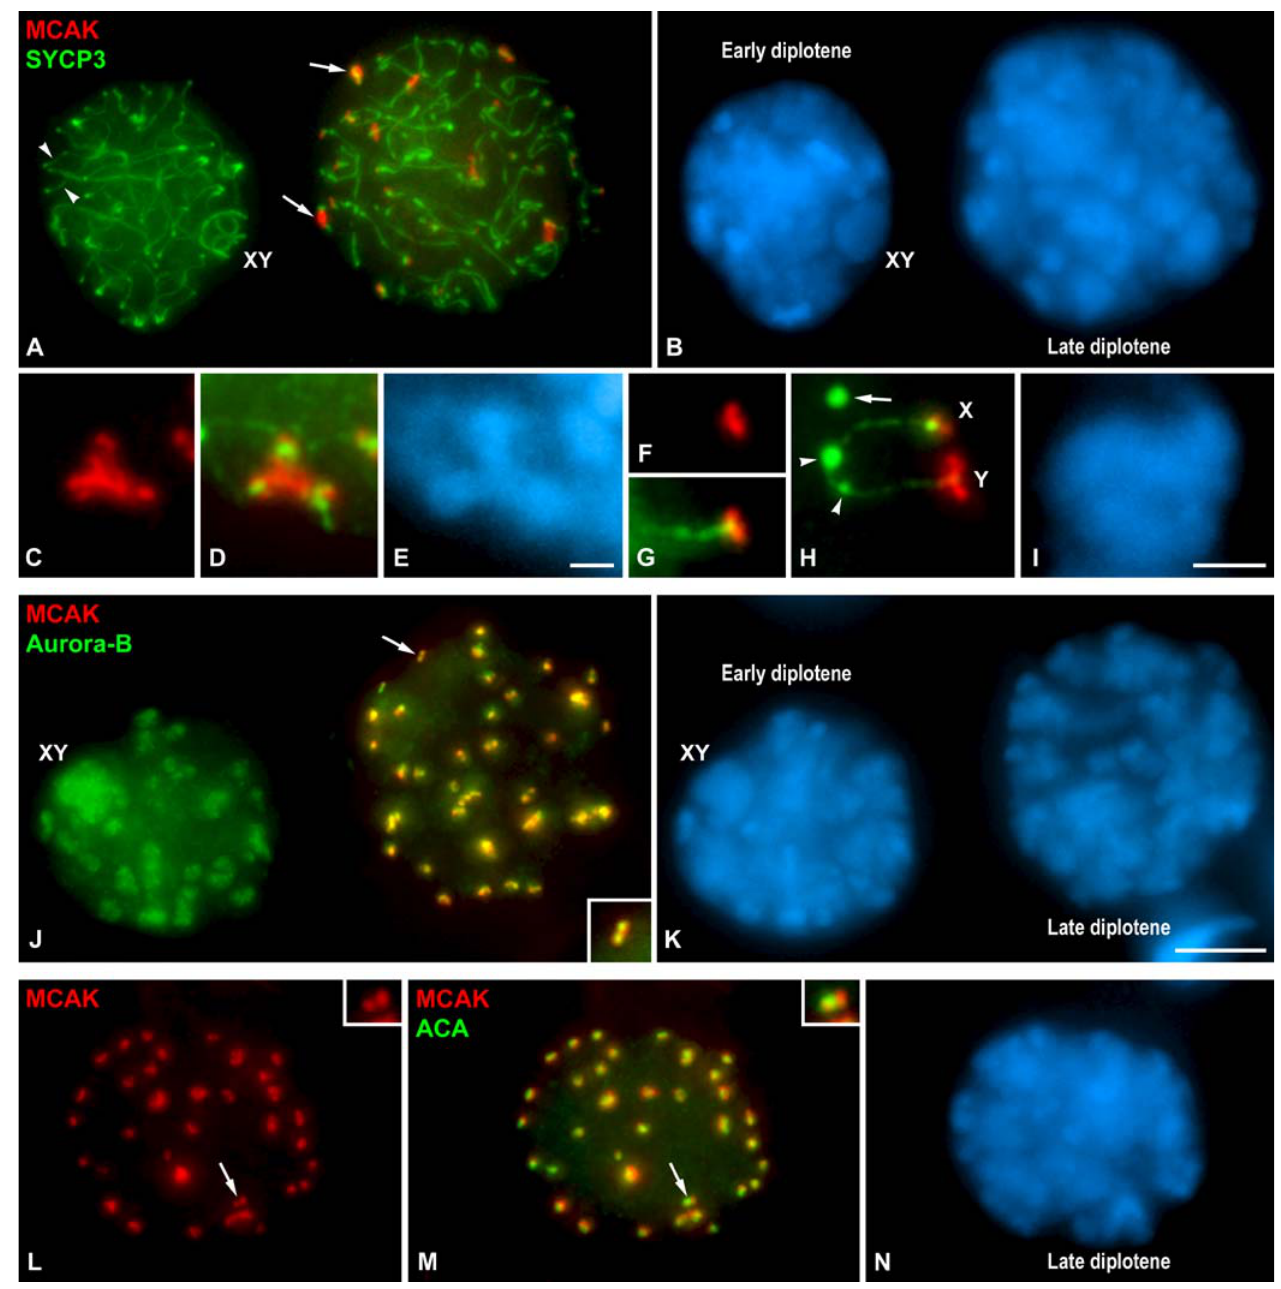
Figure 1. MCAK Is Loaded at Centromeres after Aurora-B in Late Diplotene MCAK is labelled in red and SYCP3 (A–I), Aurora-B (J,K), and kinetochores (L–N) are labelled in green. In merged images colocalisation regions appear in yellow. DNA appears in blue. Most images are z-projections of several focal planes throughout the spermatocytes shown. (A and B) Early and late diplotene spermatocytes. At early diplotene SYCP3 labels desynapsing LEs (arrowheads in [A]), and the X and Y axial elements (XY). At this stage no MCAK labelling can be detected. Nevertheless, during late diplotene, when most LEs are desynapsed, MCAK can be detected as small dots at one of their ends (arrows in [A]). (C–E) Single focal plane of a late diplotene chromocentre. MCAK occupies part of the heterochromatin and colocalises partially with the proximal ends of three desynapsed LEs detected with SYCP3. (F and G) Single focal plane of the centromeric region of a late diplotene autosome. MCAK is detected as two dots at the end of a desynapsed LE. (H and I) Projection of three focal planes of the sex bivalent (X,Y) in diakinesis. While the Y centromere appears scarcely stained for SYCP3, MCAK shows an intense T-like labelling. By contrast, the MCAK labelling at the X centromere is fainter. Note that there is one SYCP3 agglomerate in the nucleoplasm (arrow), and two SYCP3 accumulations on the axial elements (arrowheads). (J and K) Early and late diplotene spermatocytes. At early diplotene, Aurora-B appears at chromocentres and the sex body (XY). MCAK becomes first detectable at centromeres in late diplotene mostly colocalising with Aurora-B. The arrow indicates the enlarged region shown in the inset. (L–N) Late diplotene spermatocyte. The MCAK signals appear close to the kinetochore ones, that have been revealed with an anti-centromere autoantibody serum. The arrowed signal has been enlarged in the inset where it can be discerned that a single kinetochore is located in between two MCAK signals. Bars, 5 l m (A,B,J,K,L–N), 1 l m (C–E), and 2 l m (F–I). DOI: 10.1371/journal.pgen.0020084.g001 PLoS Genetics |